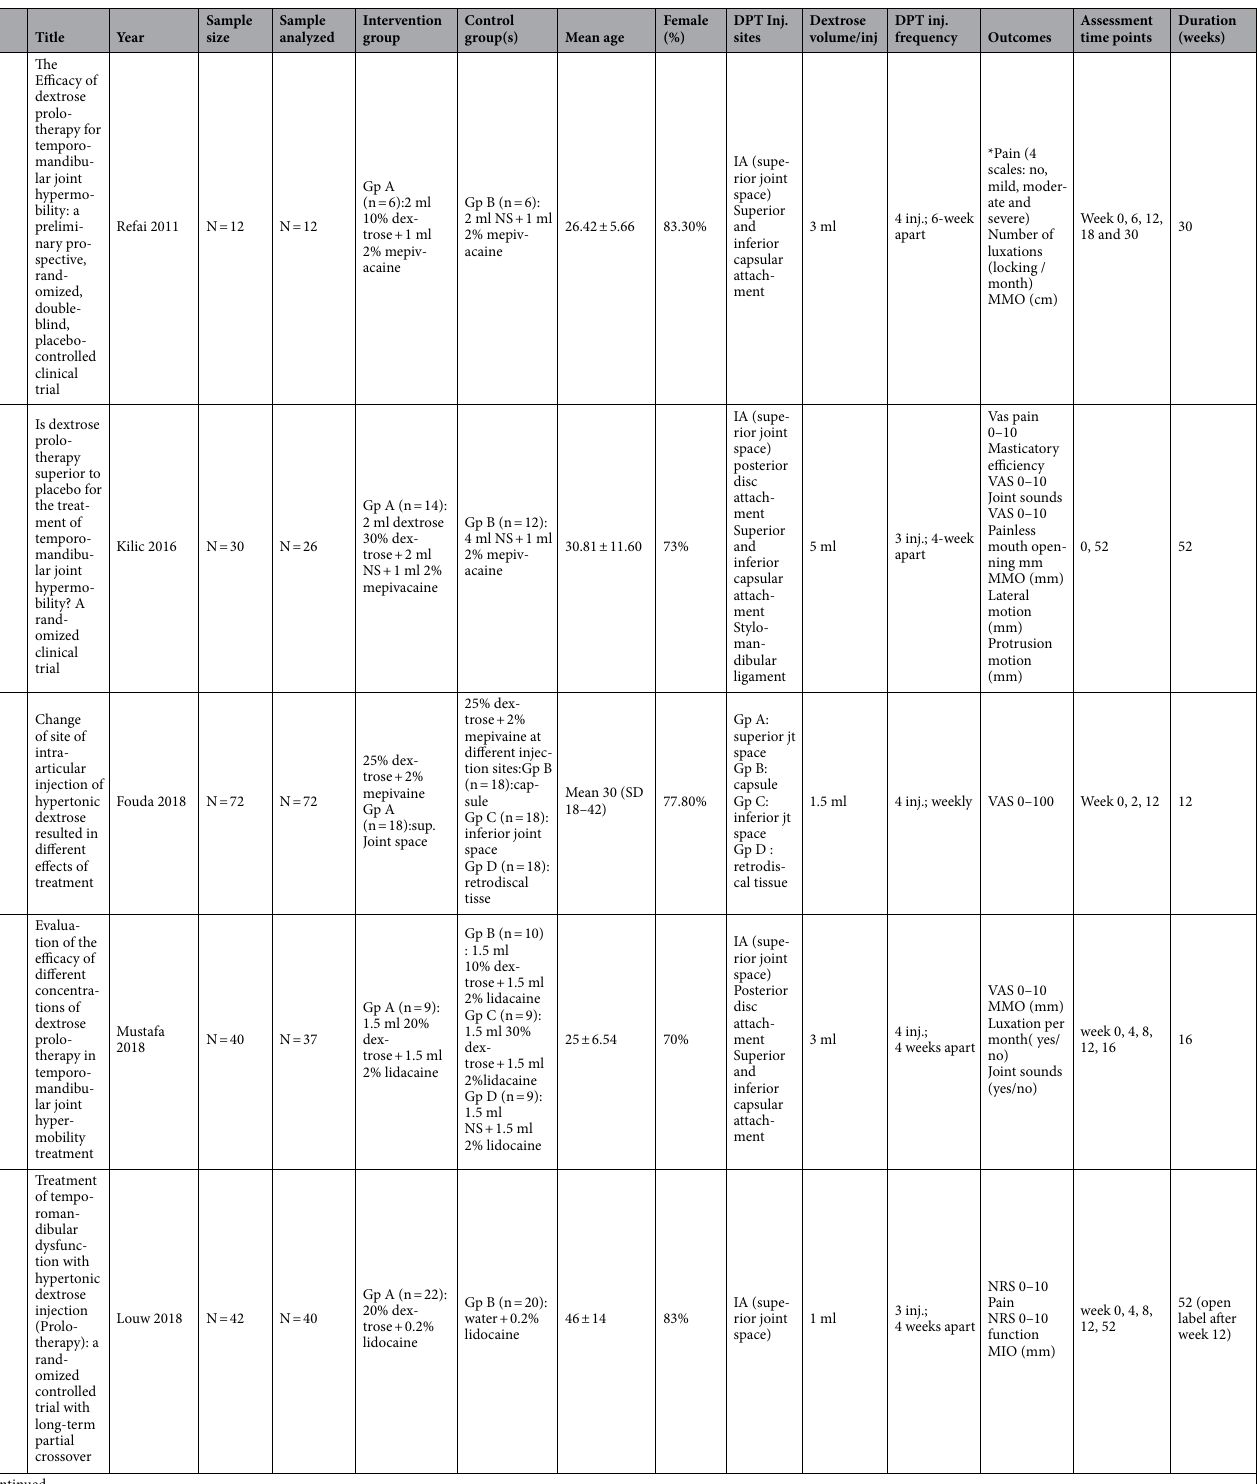
The Efficacy of dextrose prolo- therapy for temporo- mandibu- lar joint hypermo- bility: a prelimi- nary pro- spective, rand- omized, double- blind, placebo- controlled clinical trial Is dextrose prolo- therapy superior to placebo for the treat- ment of temporo- mandibu- lar joint hypermo- bility? A rand- omized clinical trial Change of site of intra- articular injection of hypertonic dextrose resulted in different effects of treatment Evalua- tion of the efficacy of different concentra- tions of dextrose prolo- therapy in temporo- mandibu- lar joint hyper- mobility treatment Treatment of tempo- roman- dibular dysfunc- tion with hypertonic dextrose injection (Prolo- therapy): a rand- omized controlled trial with long-term partial